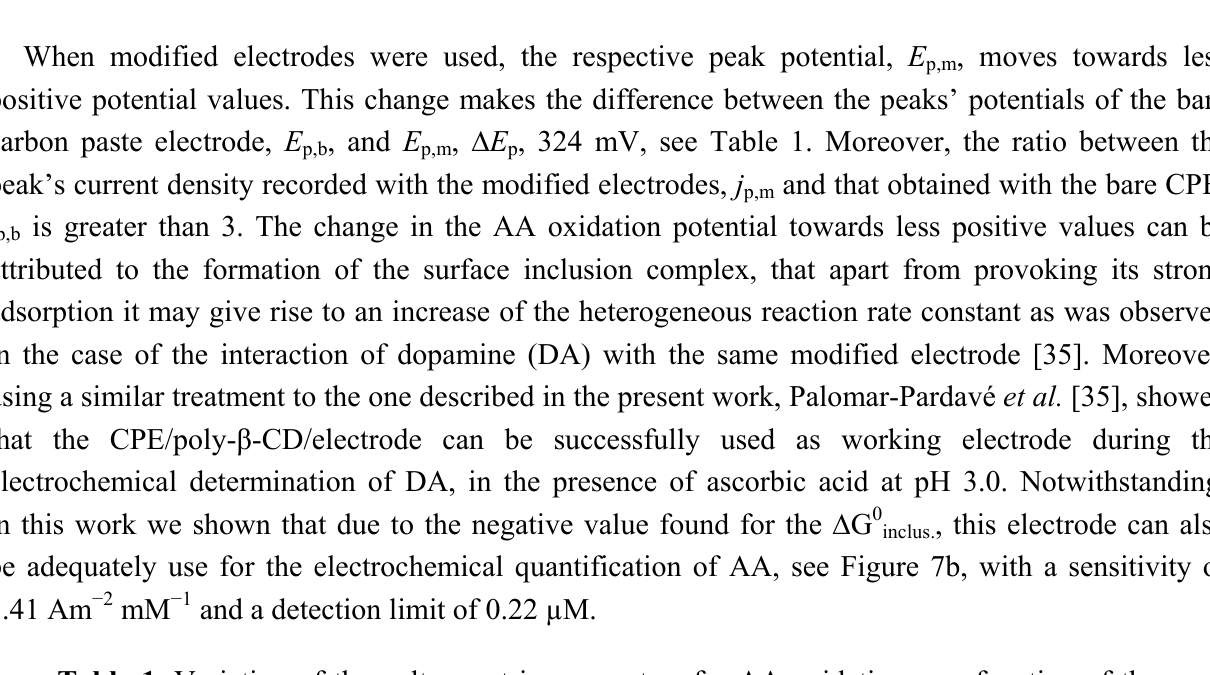
Table 1. Variation of the voltammetric parameters for AA oxidation as a function of the electrode